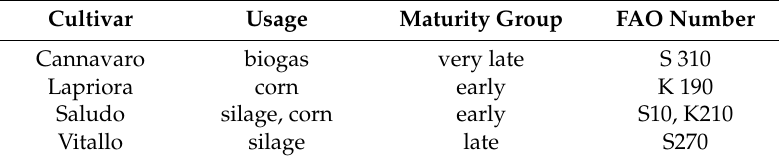
Table 1. Intended use, maturity class and number of the different maize cultivars. Cultivar Usage Maturity Group FAO Number Cannavaro biogas very late Lapriora corn silage, corn